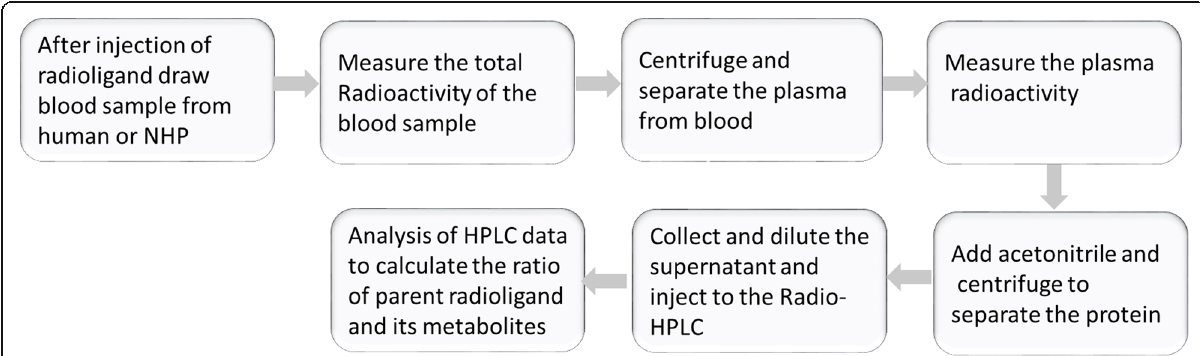
Fig. 1 The schematic diagram of protein elimination from the blood sample